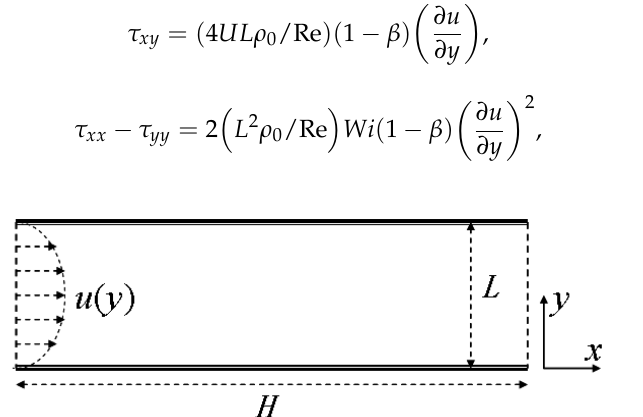
Figure 2. Channel flow set up parameters.